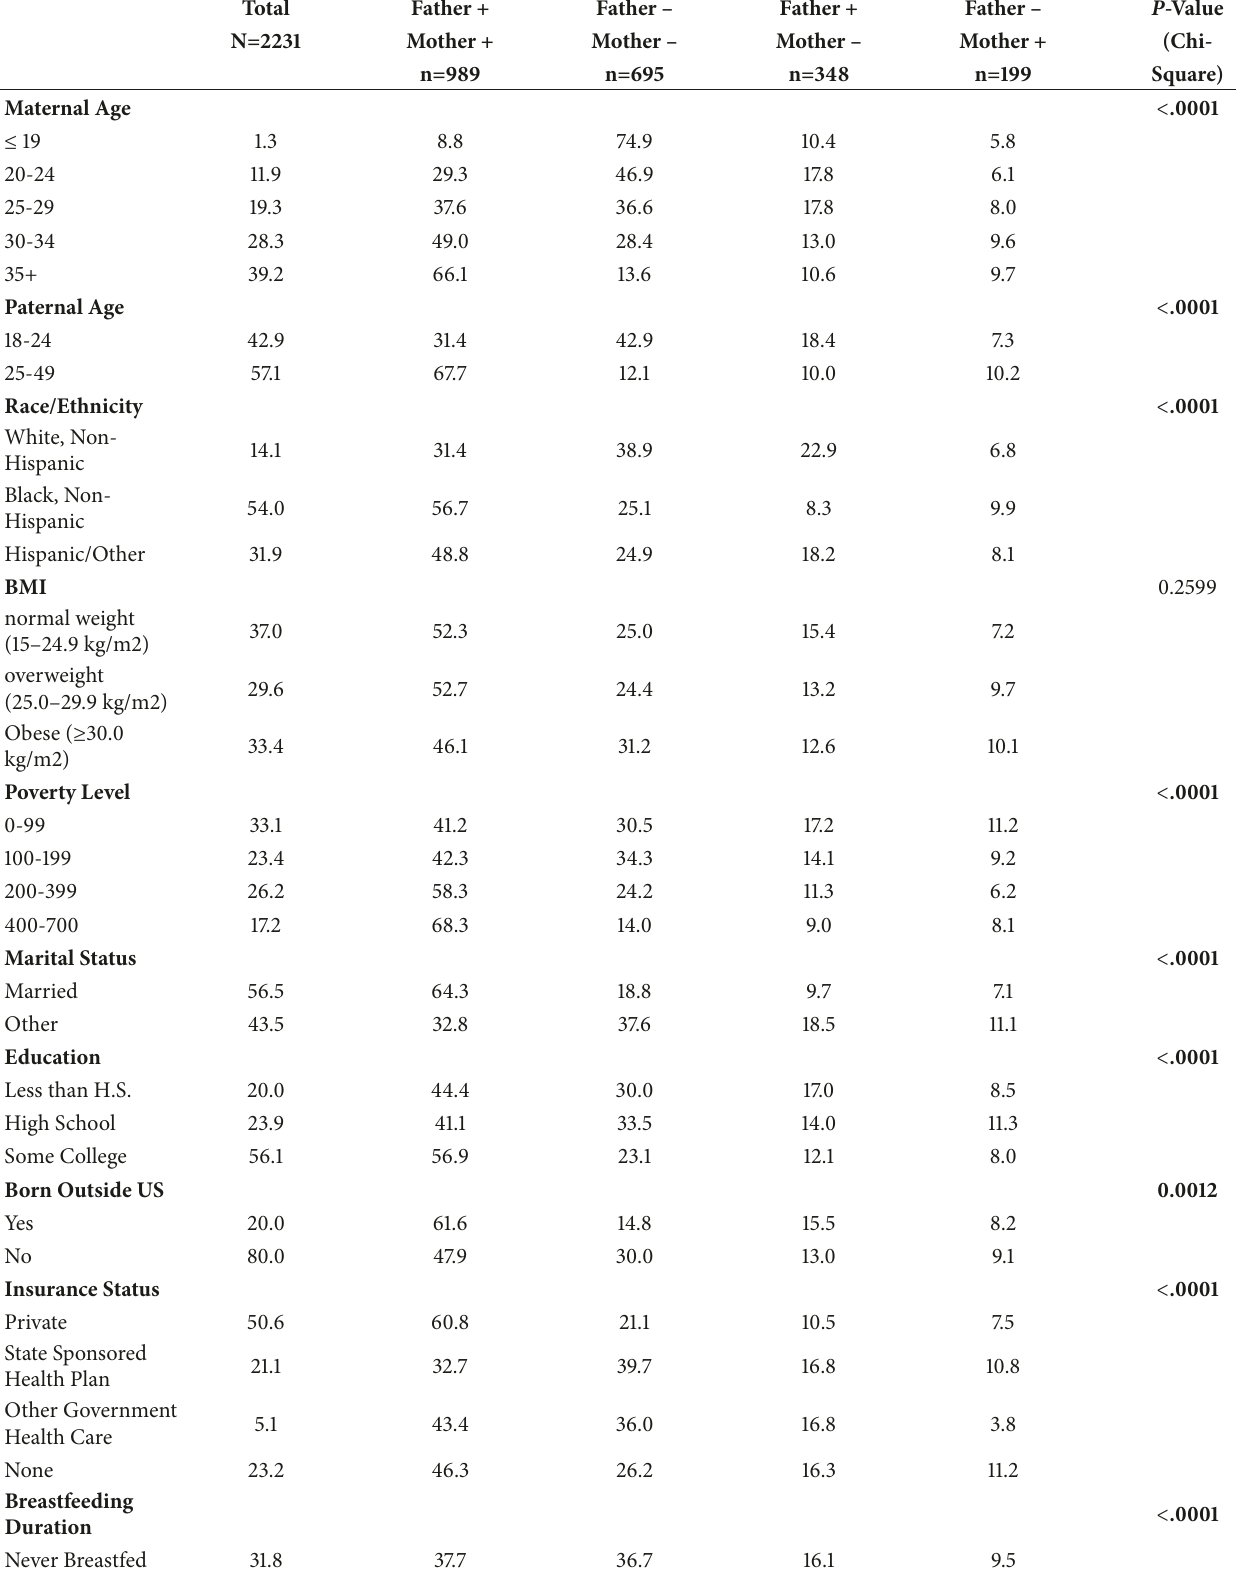
Table 1: Weighted distribution of characteristics by couple pregnancy intention among US